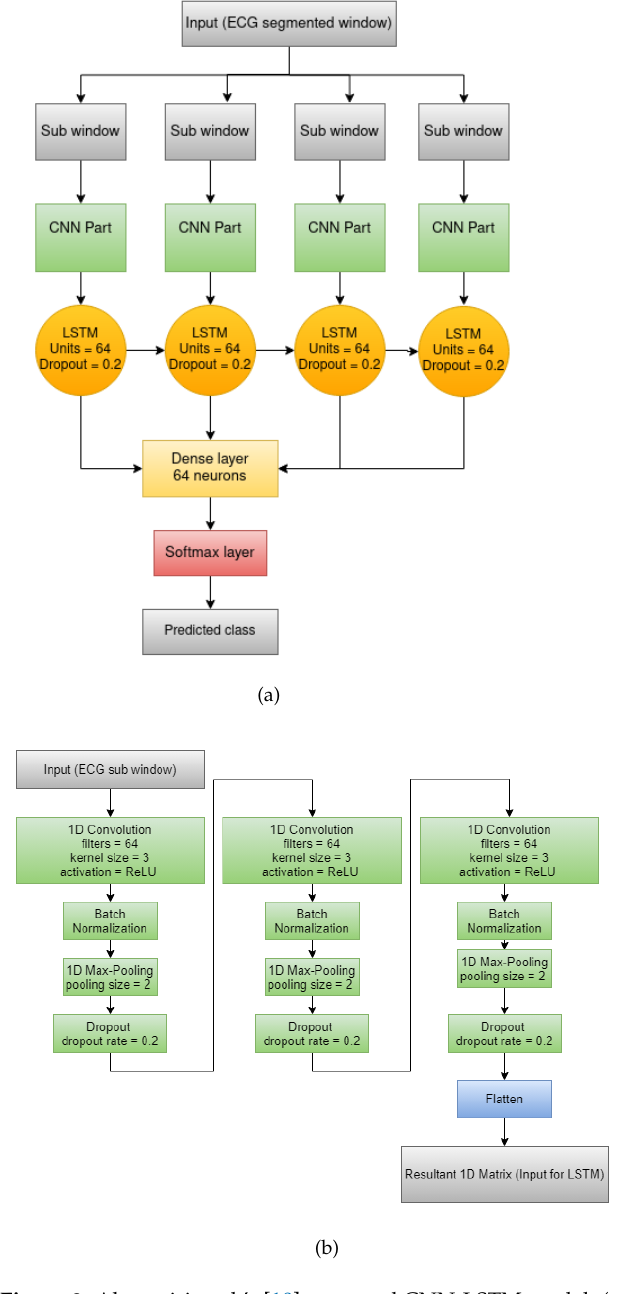
Figure 3. Almutairi et al.’s [10] proposed CNN-LSTM model: ( a ) overall architecture, ( b ) architecture of the CNN part present in the overall